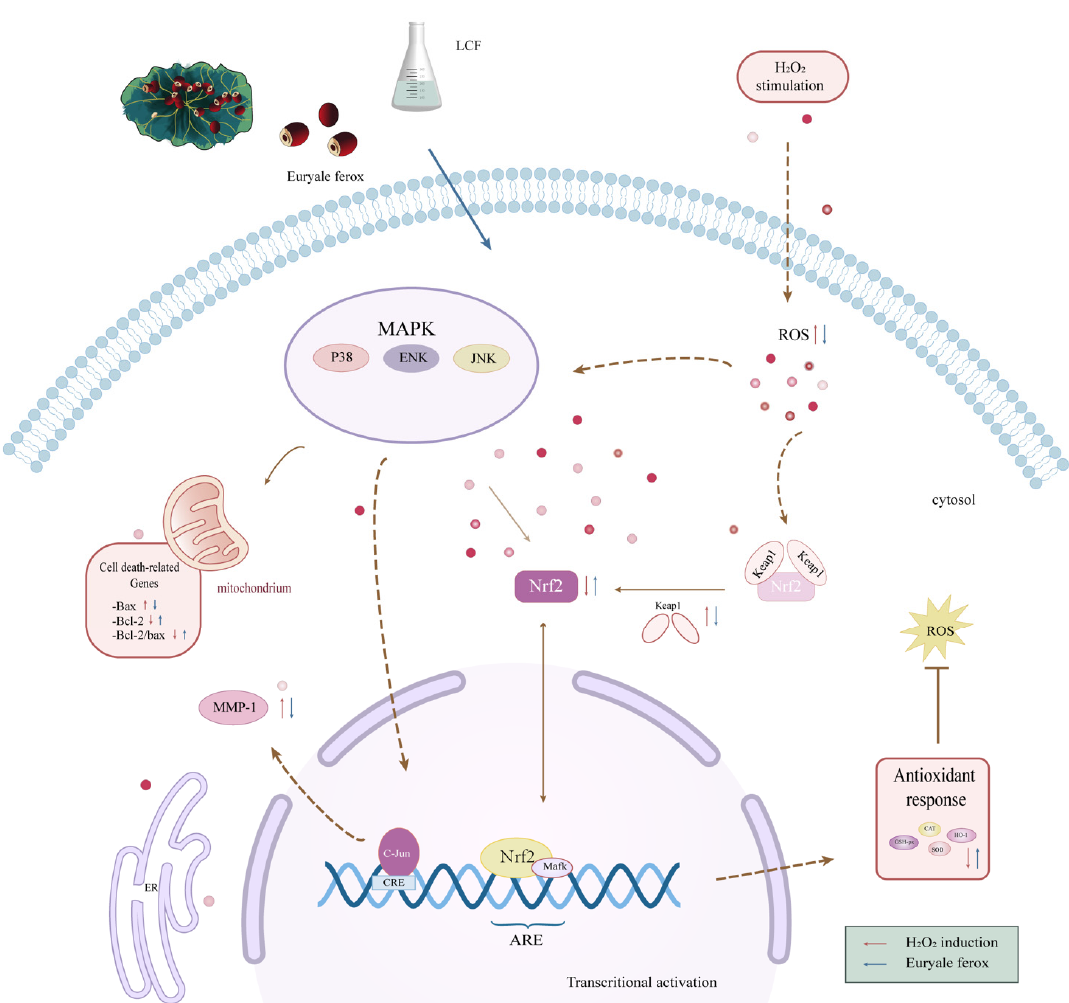
Figure 13. The oxidative stress pathway of Nrf2/Keap1/Mafk.